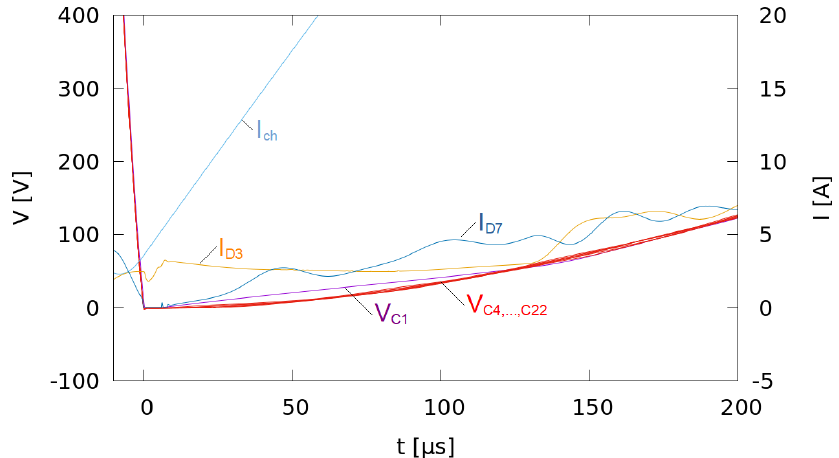
Figure 22. voltages across the capacitors C1 (V C1 )and C4, C7, C10, C13, C16, C19, and C22 (V C4,…,C22 ), currents through D3 (I D3 ) and D7 (I D7 ) according to Figure 3 together with the generator’s charging current I ch (R D = 20 Ohm, on-time of the solid-state switches: t on = 22 µs).